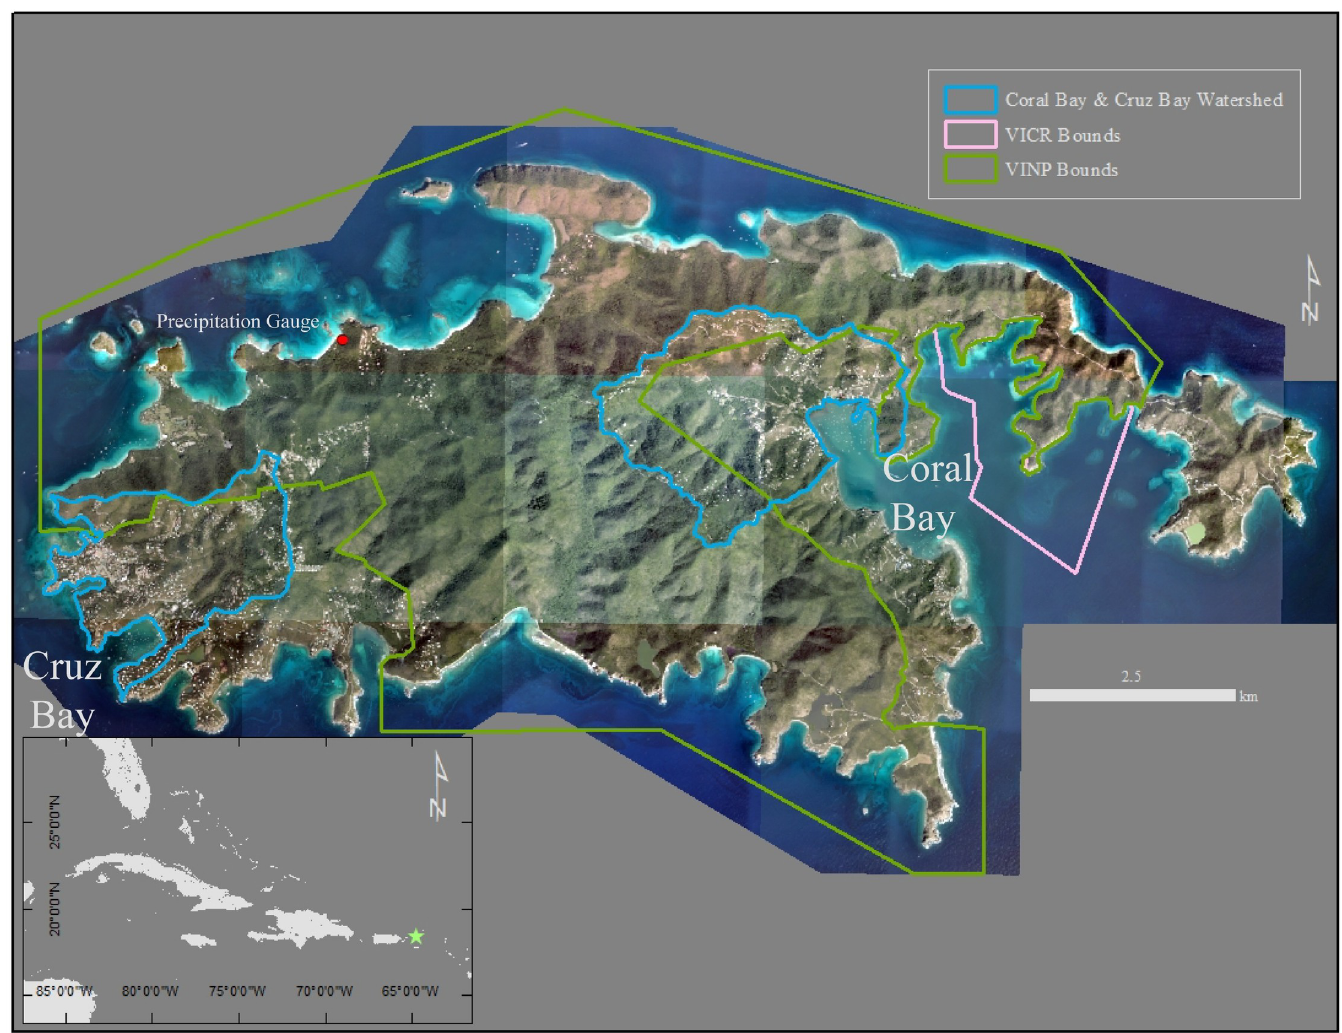
Fig 1. Satellite image of St. John, US Virgin Islands. Green star indicates the location of St. John on the inset map. The watersheds of Coral Bay and Cruz Bay are outlined in blue. The Virgin Islands National Park (green outline) encompasses the majority of St. John’s landmass while the Virgin Islands Coral Reef National Monument (pink outline) protects offshore of Coral Bay. Note the Virgin Islands Coral Reef National Monument covers a greater offshore area than is shown on this map. The location of the precipitation gauge used in the EVI-STJ is shown in Trunk Bay. Imagery Courtesy of [53]